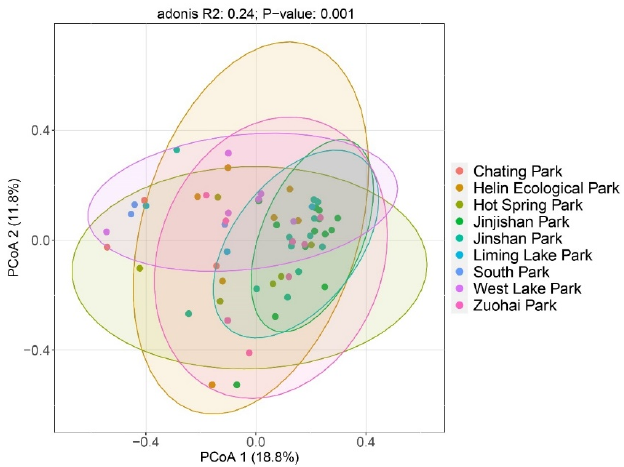
Figure 6. PcoA two-dimensional plot of overall birds from 9 urban parks.